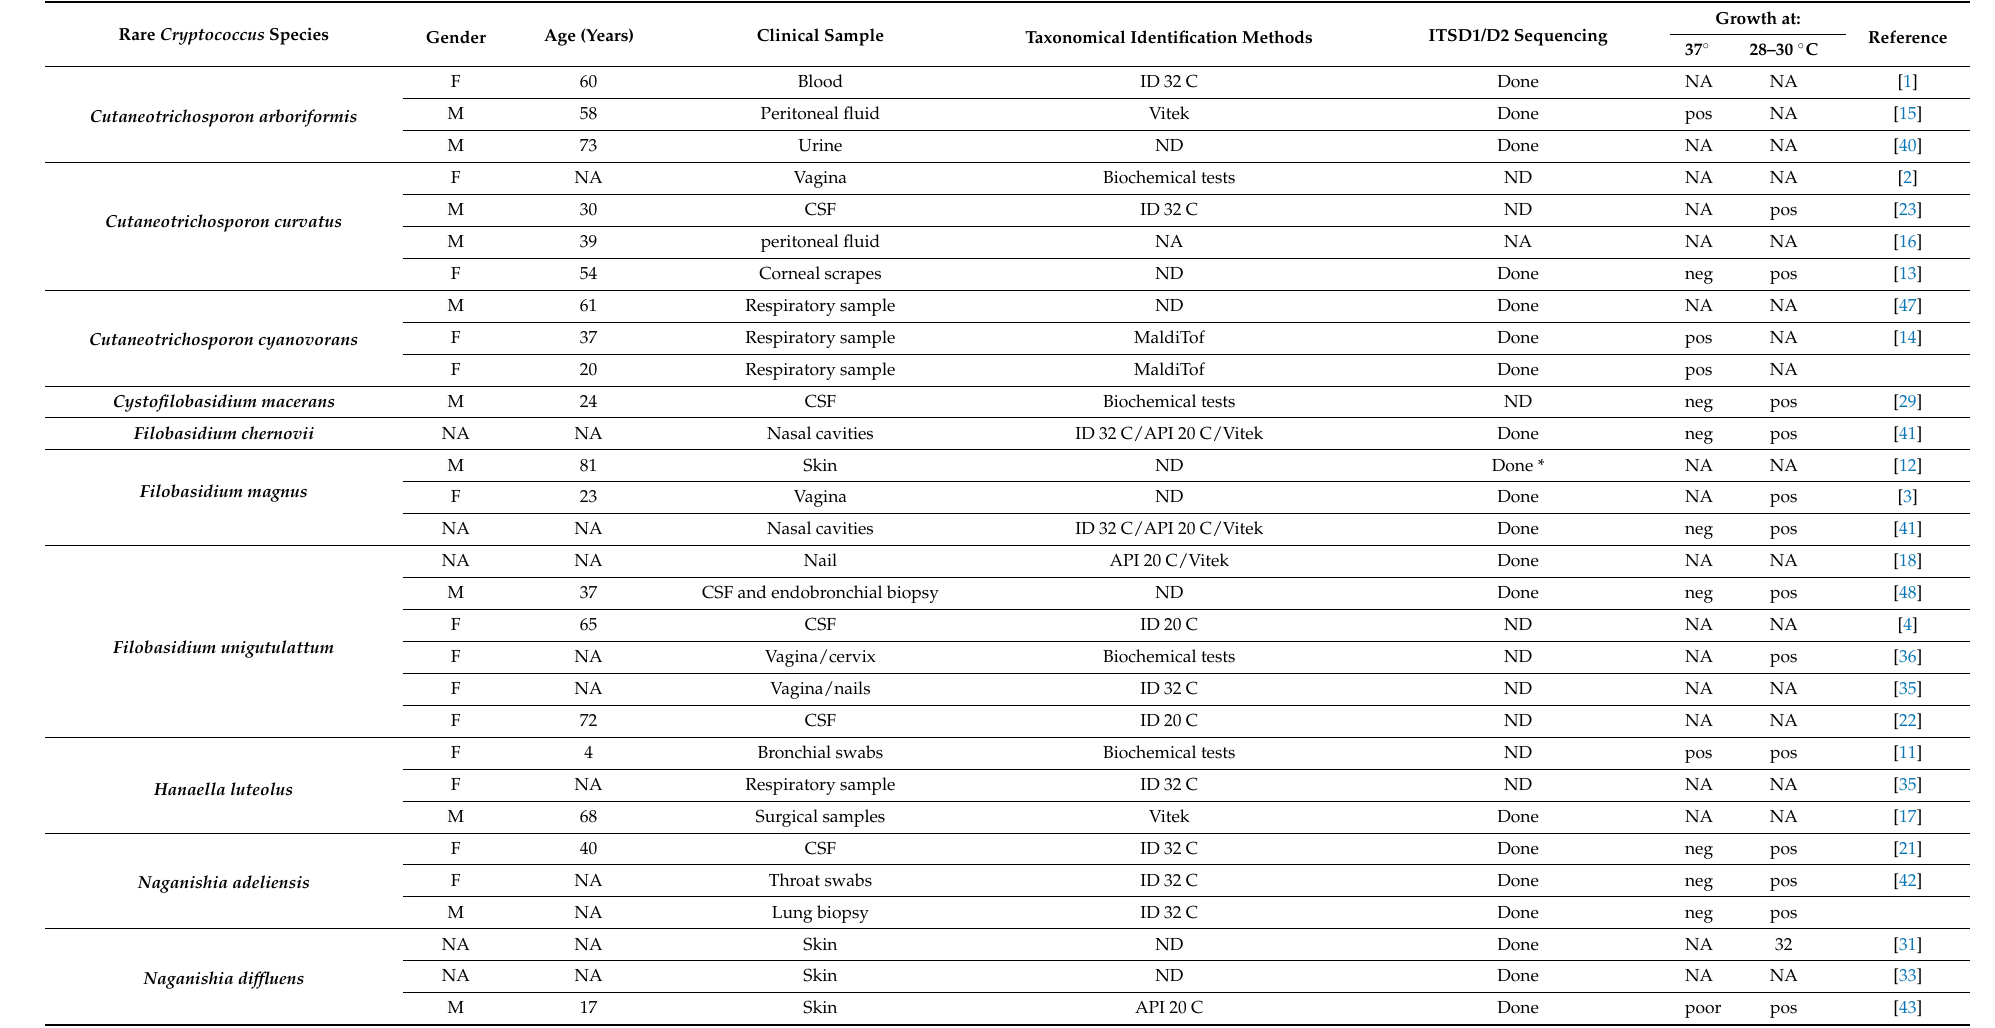
Table 1. Rare Cryptococcus spp. infections: Epidemiological data, isolation samples, and identification